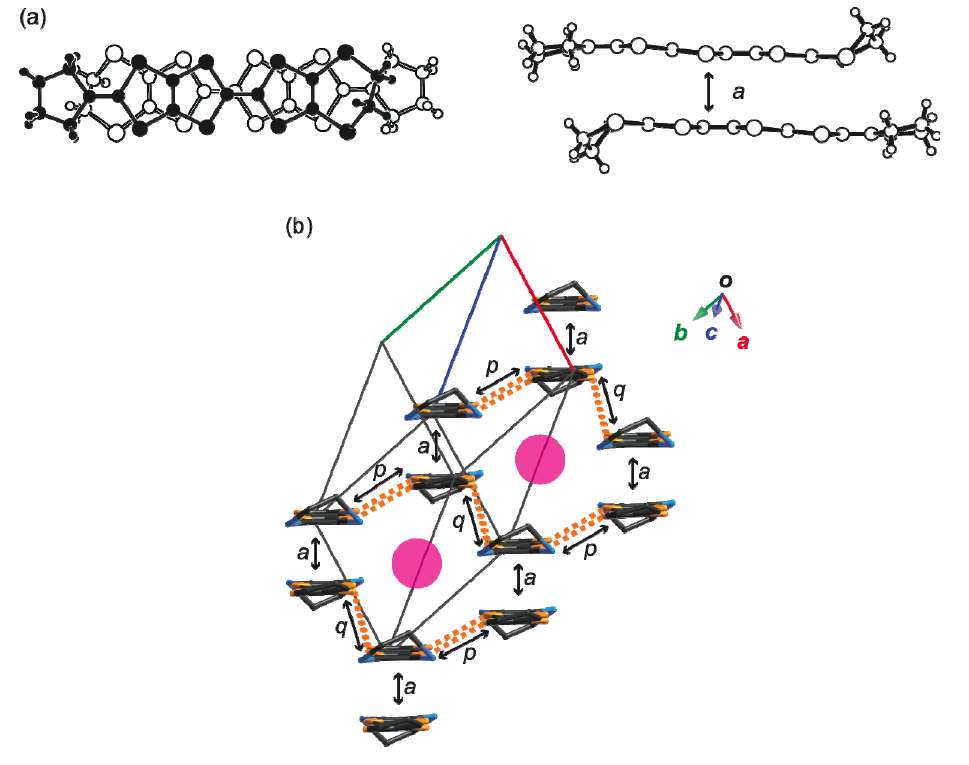
Figure 20. ( a ) Top and side views of molecular overlap of a . The atoms in the front molecule are represented by solid circles and those in the rear are represented by open circles; ( b ) Molecular arrangement viewed along the molecular long axis. The calculated overlaps integrals (×10 − 3 ) are a = 38.11, p = 3.98, and q = 7.08. Orange broken lines and pink circles indicate S···S contacts shorter than the sum of the van der Waals radii and I ion. The hydrogen atoms are omitted for clarity.